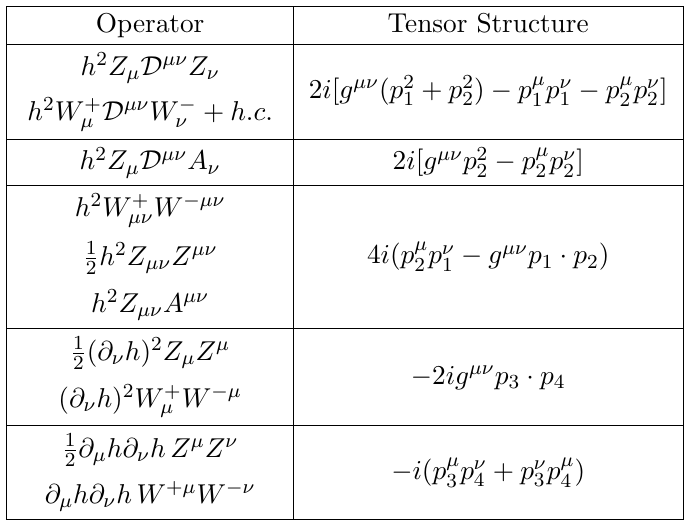
Table 6. The tensor structure of h ( p 3 ) h ( p 4 ) V 1 ( p 1 ; (cid:22) ) V 2 ( p 2 ; (cid:23) )